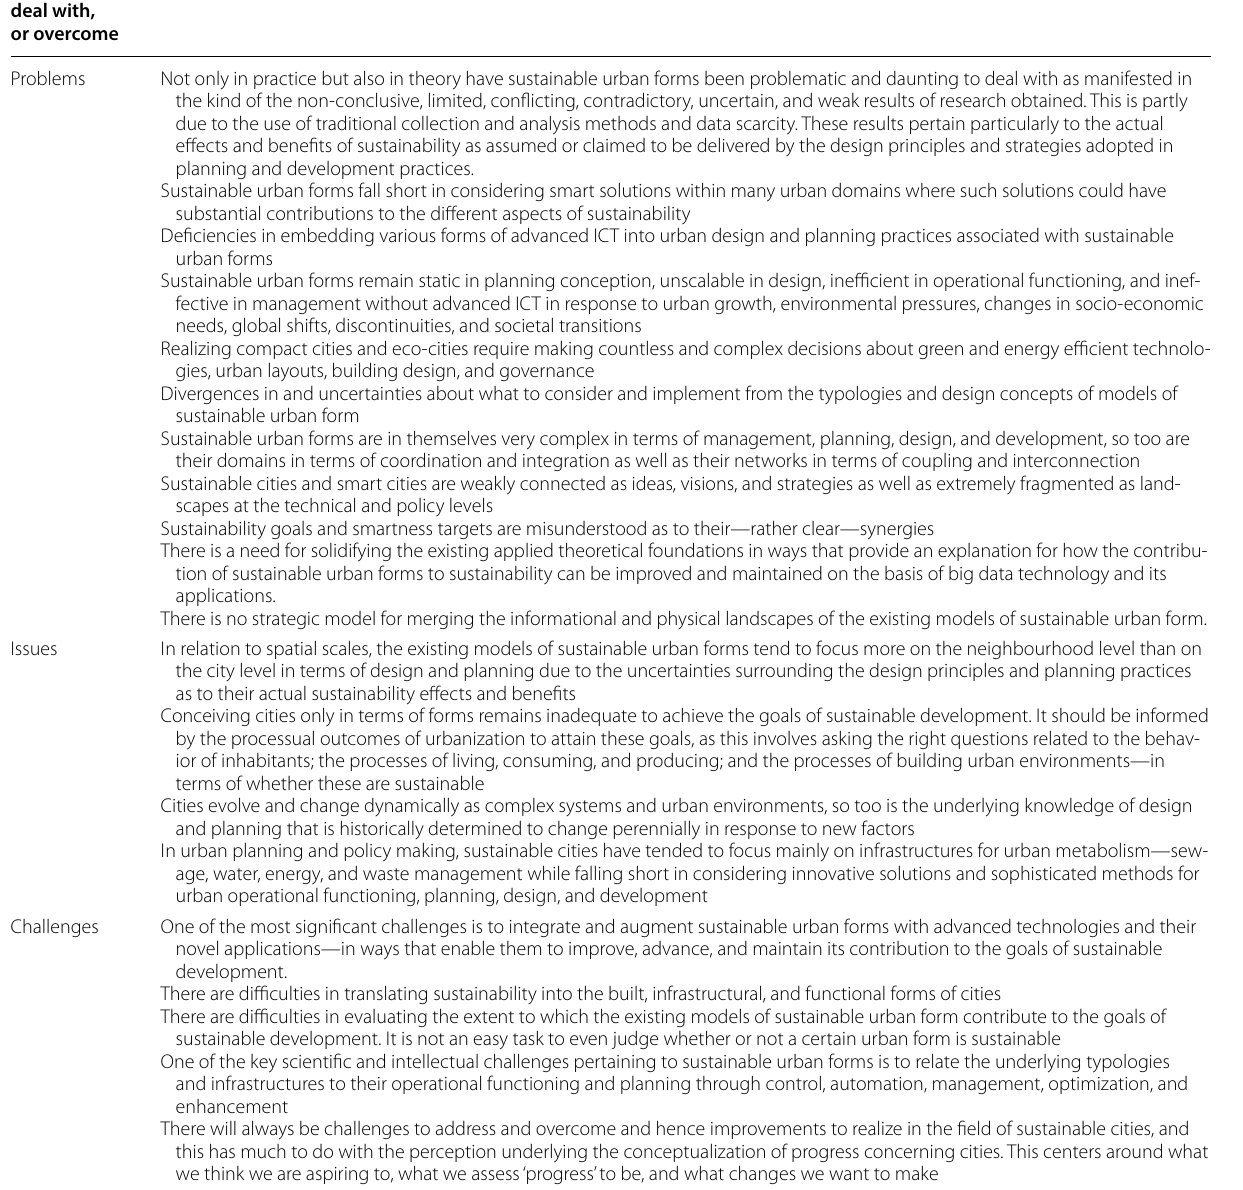
Table 3 Problems, issues, and challenges pertaining to sustainable urban forms What to solve, Deficiencies, limitations, difficulties, fallacies. and uncertainties deal with, or overcome Problems